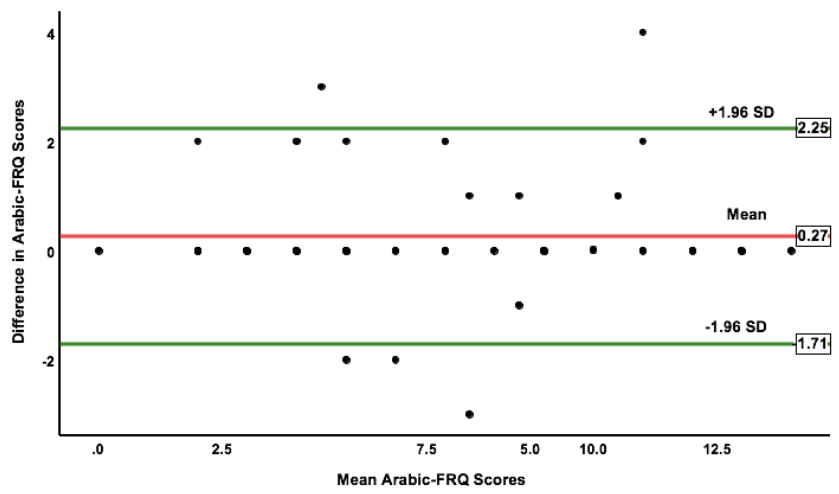
Figure 2. The 95% limits of agreement of the Arabic FRQ scores between the baseline and seven days after. FRQ, Fall Risk Questionnaire; SD, standard deviation.